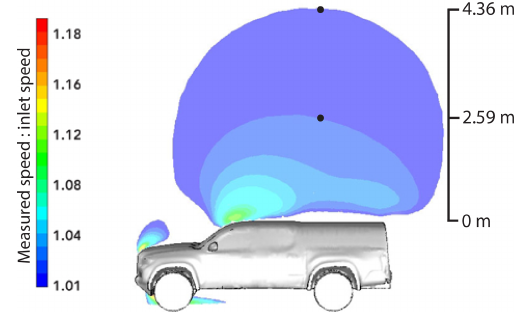
Figure 3. Frontal wind velocity contour of the truck’s longitudinal axis. The black dot at 2.59m represents the anemometer height re- quired to be subject to less than 2% bias, and the black dot at 4.36m represents the anemometer height required to be subject to less than 1% bias, if mounted 30cm behind the truck cab. Table 2. Required anemometer height for a centrally mounted anemometer to experience negligible